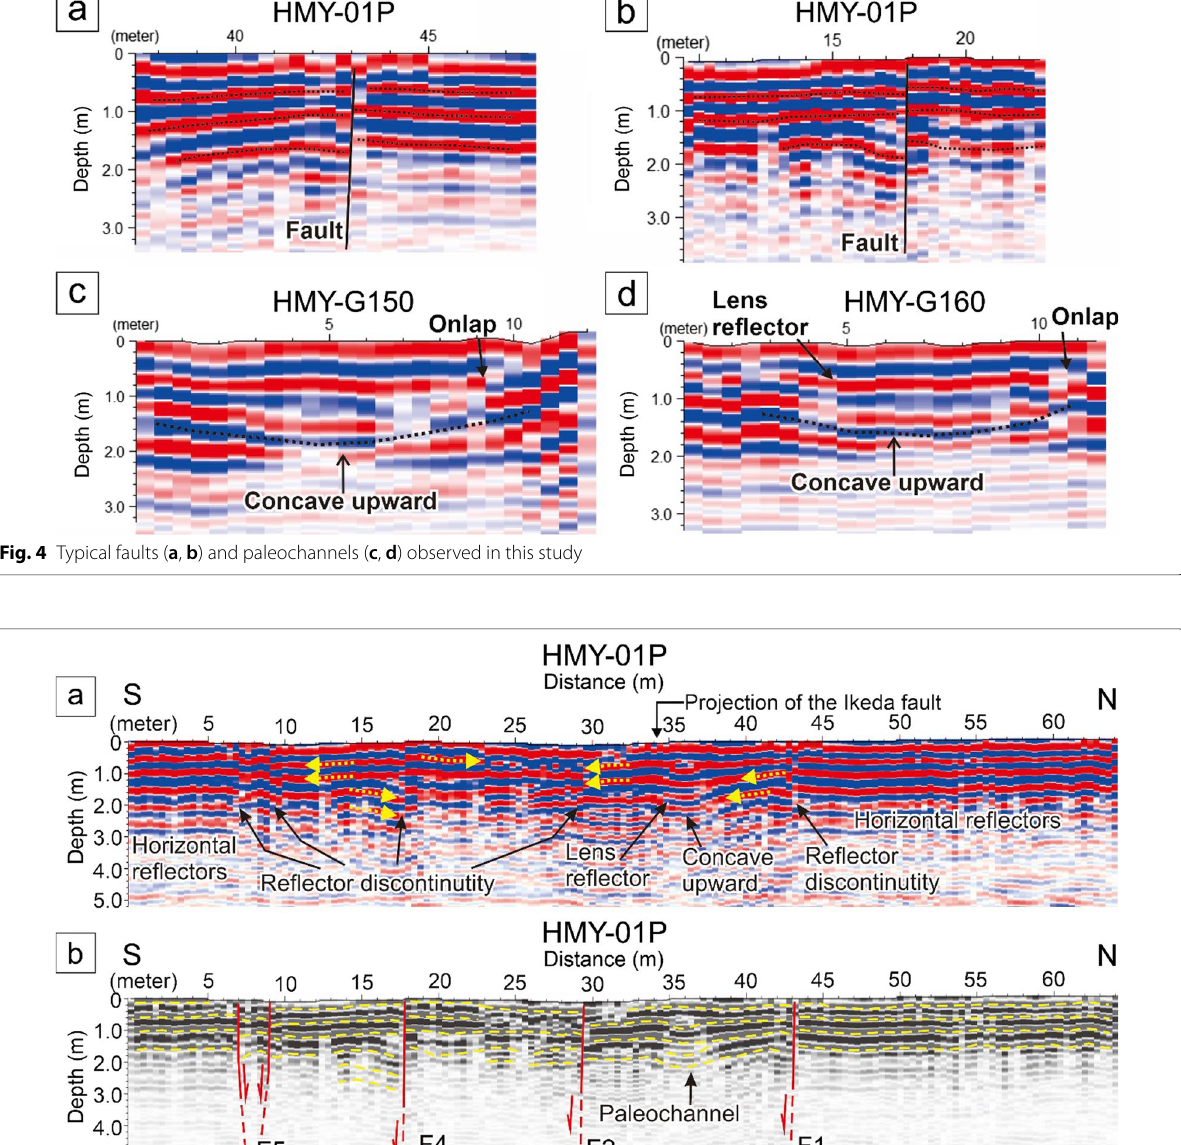
horizontal reflectors characterize the section from HD 19 to the northern end.